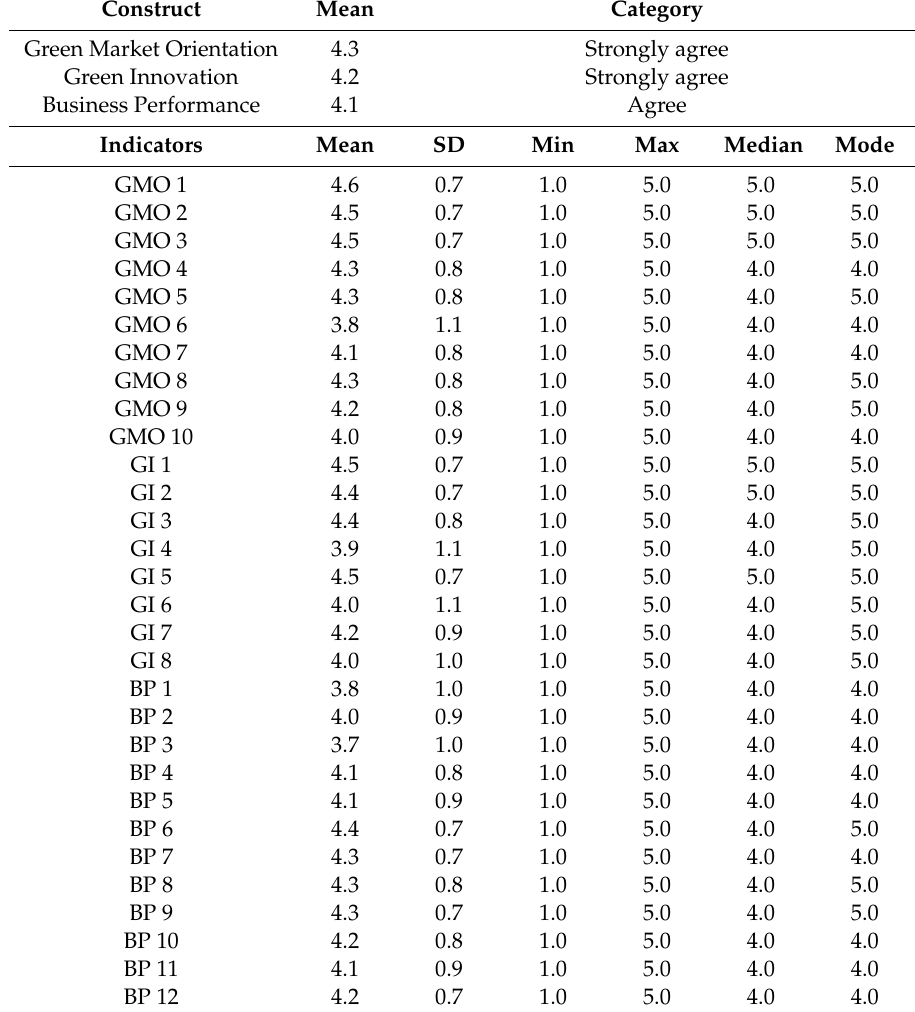
Table 2. Results of descriptive